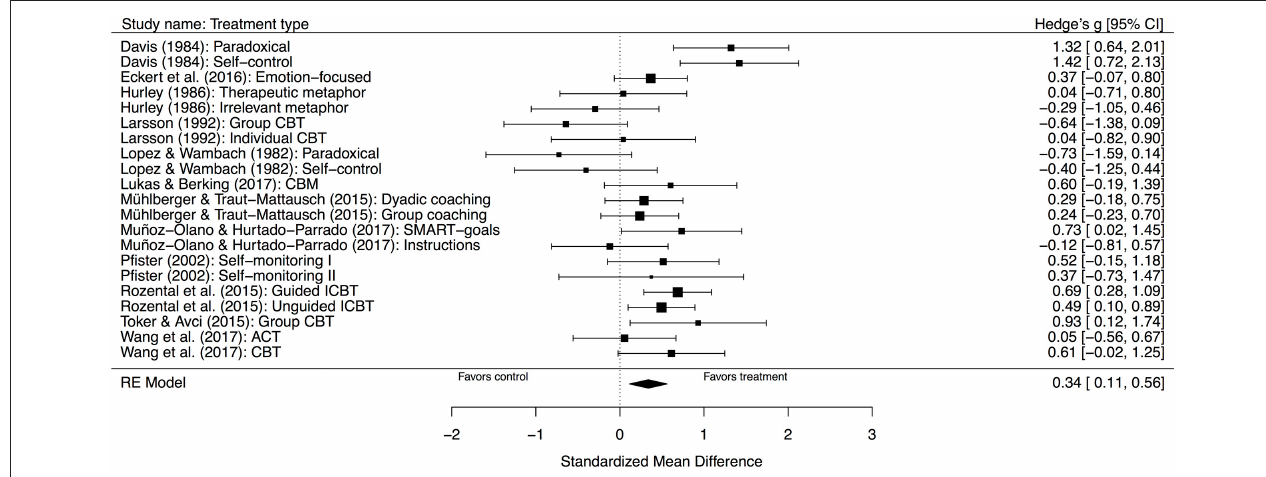
FIGURE 2 | Forest plot displaying the effect sizes of studies comparing psychological treatments with inactive comparators. RE, random effects; CI, confidence interval.